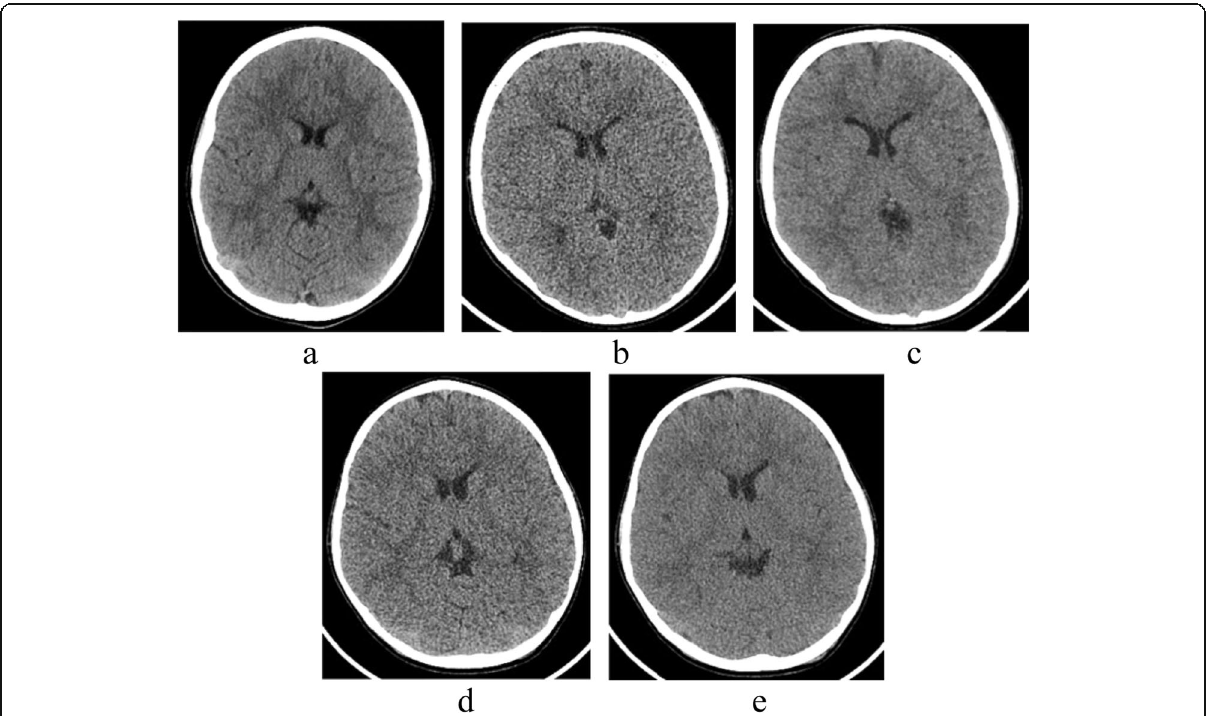
Fig. 6 Image quality of CT images at the level of thalamus. Non-ASIR CT image ( a ), 60% ASIR-V ( b ), and 80% ASIR-V ( c ) CT images using 80-mA tube current reduced CT protocol, and 60% ASIR-V ( d ) and 80% ASIR-V ( e ) CT images using 100-mA tube current reduced CT